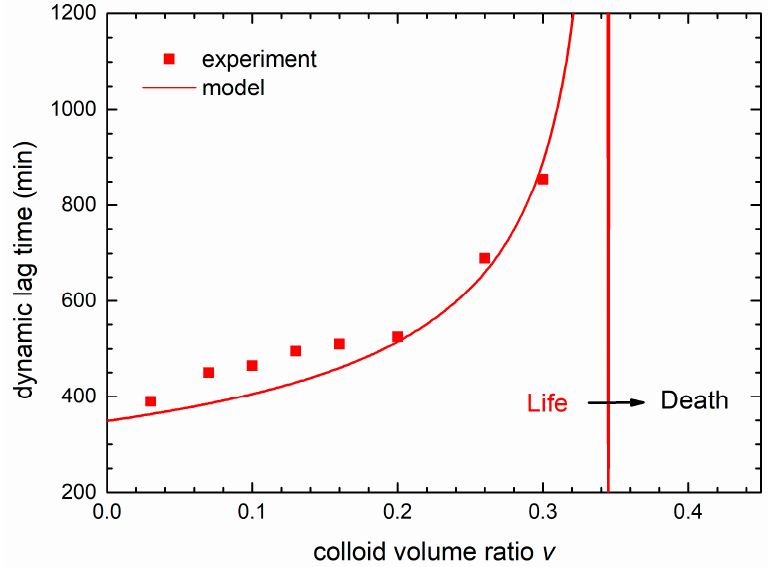
Figure 9. The dependence of the dynamic lag time on the colloid volume share v . The squares are the data obtained from the experimental growth curves and the solid line are the calculated data obtained from the theoretical model. The limit between bacterial life and death conditions (lethal treatment) is denoted by the vertical dashed line.